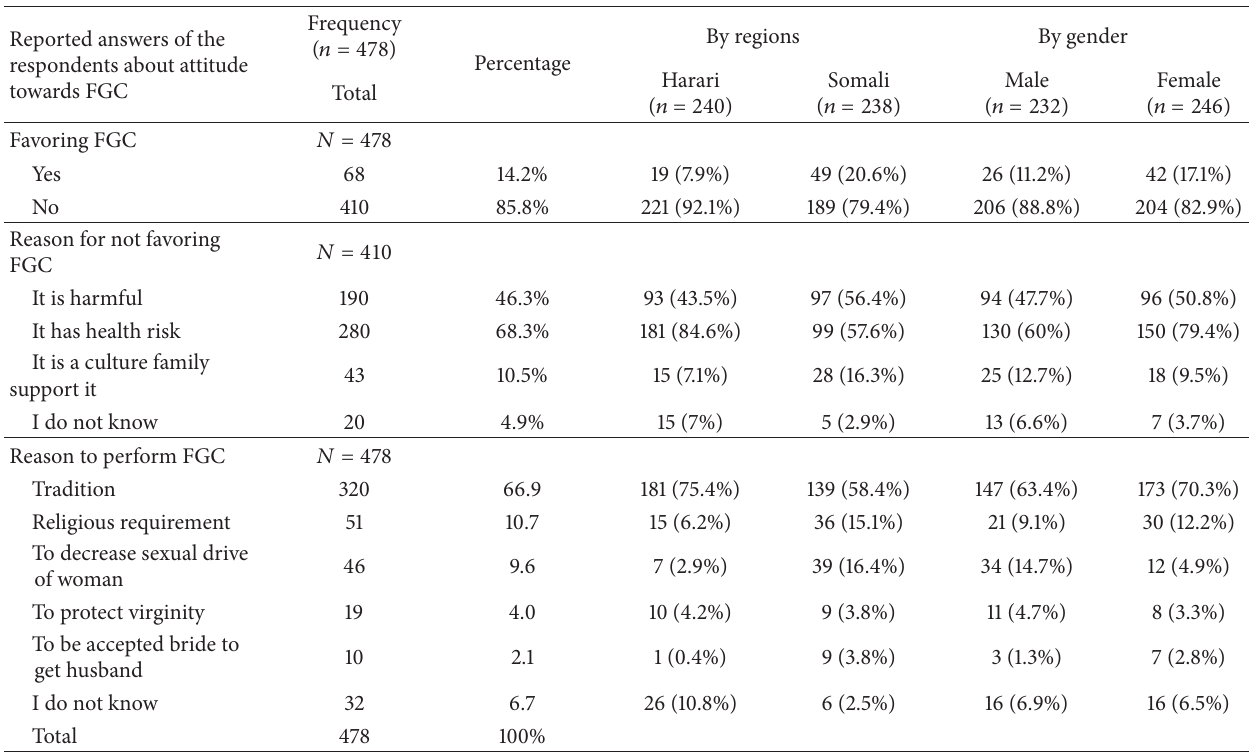
Table 2: Group differences in attitude towards FGC in Somali and Harari regions, Eastern Ethiopia.